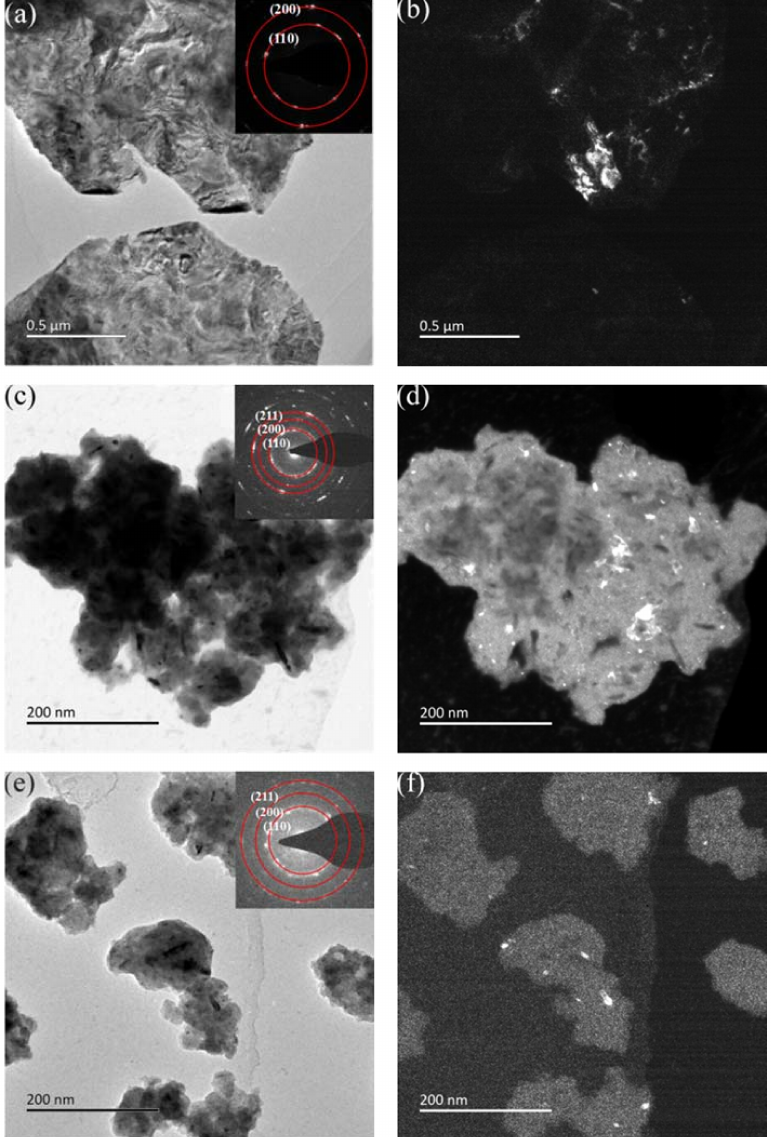
Figure 4. The TEM images of ball-milled tungsten powder with 8% process control agent (PCA) and different milling speeds. ( a ) 300 rpm, 60 h, BF TEM image; ( b ) 300 rpm, 60 h, DF TEM image; ( c ) 500 rpm, 60 h, BF TEM image; ( d ) 500 rpm, 60 h, DF TEM image; ( e ) 700 rpm, 60 h, BF TEM